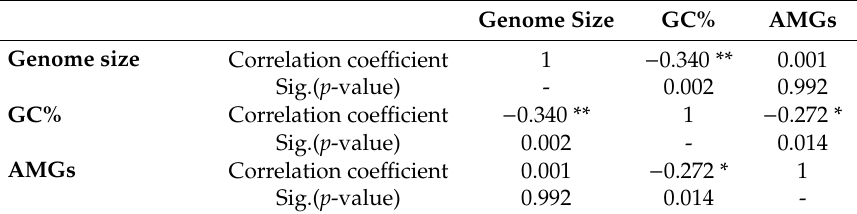
Table 2. Spearman’s rank correlation coe ffi cient between genome size, G + C content and AMGs. *: p < 0.05; **: p < 0.01; n =